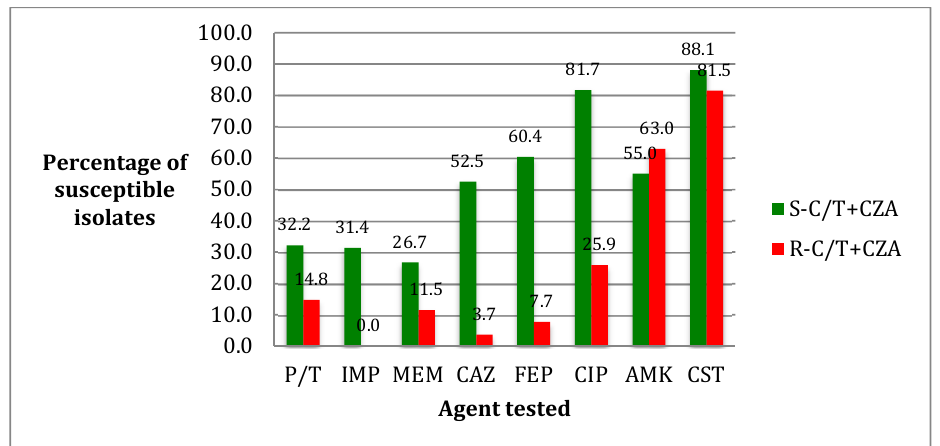
Figure 1. Comparison of susceptibility rates between S-C/T+CZA and R-C/T+CZA PA isolates. Abbreviations: P/T: piperacillin/tazobactam; IMP: imipenem; MEM: meropenem; CAZ: ceftazidime; FEP: cefepime; CIP: ciprofloxacin; AMK: amikacin; and CST: colistin.